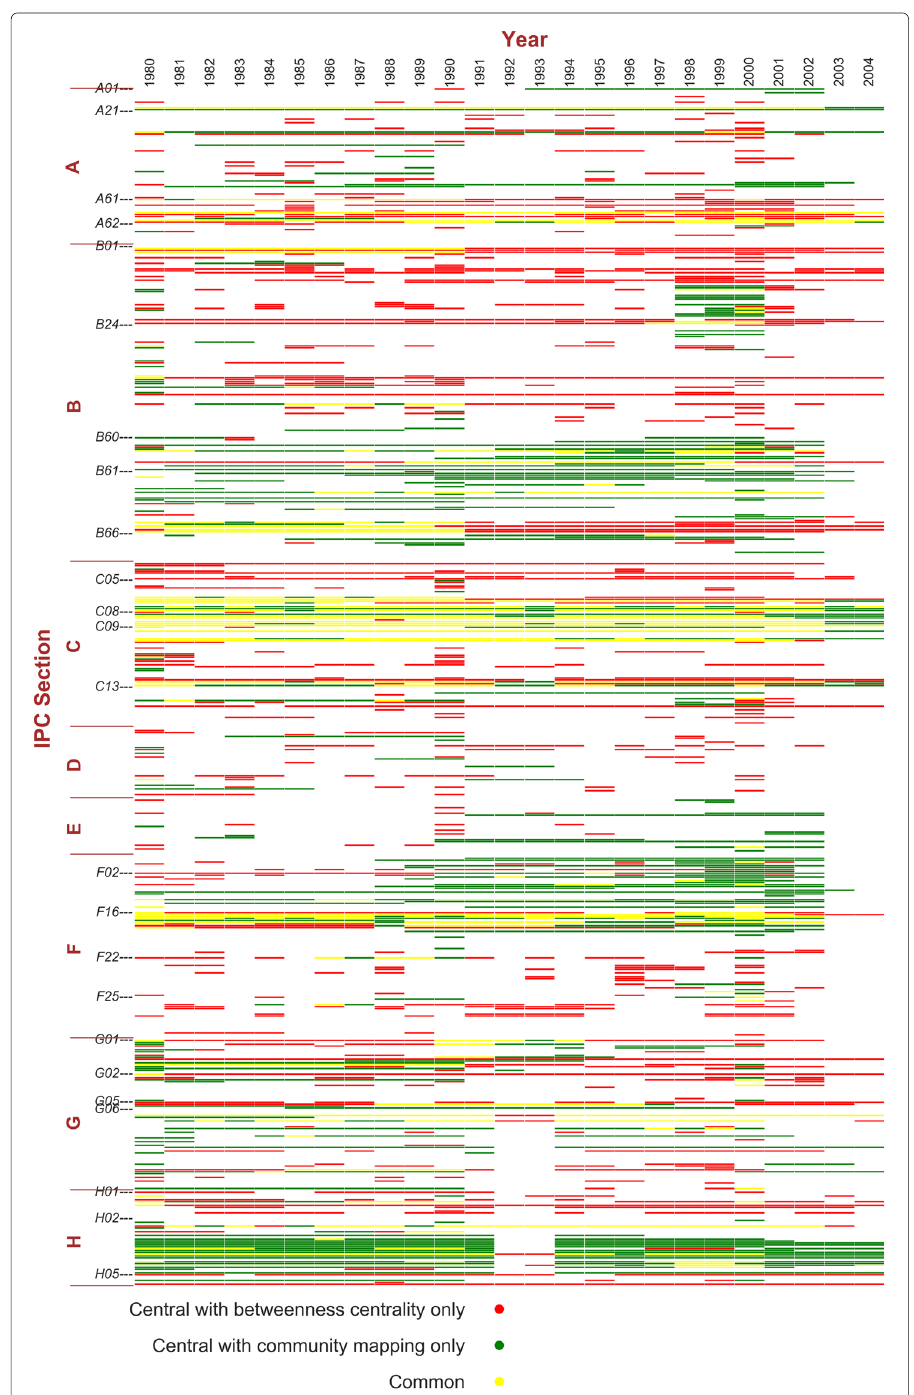
Fig. 7 Central Nodes Distribution by Comparing the Community Mapping Method with the Betweenness Centrality Method. The x-axis indicates years from 1980 to 2004, and the y-axis indicates the nodes, i.e. IPC subclasses, ordered in IPC index. The community mapping is based on consecutive 10-year windows. Betweenness centrality values are calculated on 3-year aggregation period started with the same labeled year as the other method. Colored blocks indicate the central nodes in common and different between the two method, following the